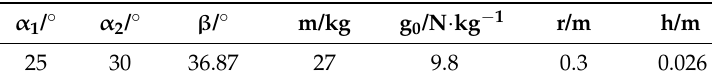
Table 1. Simulation